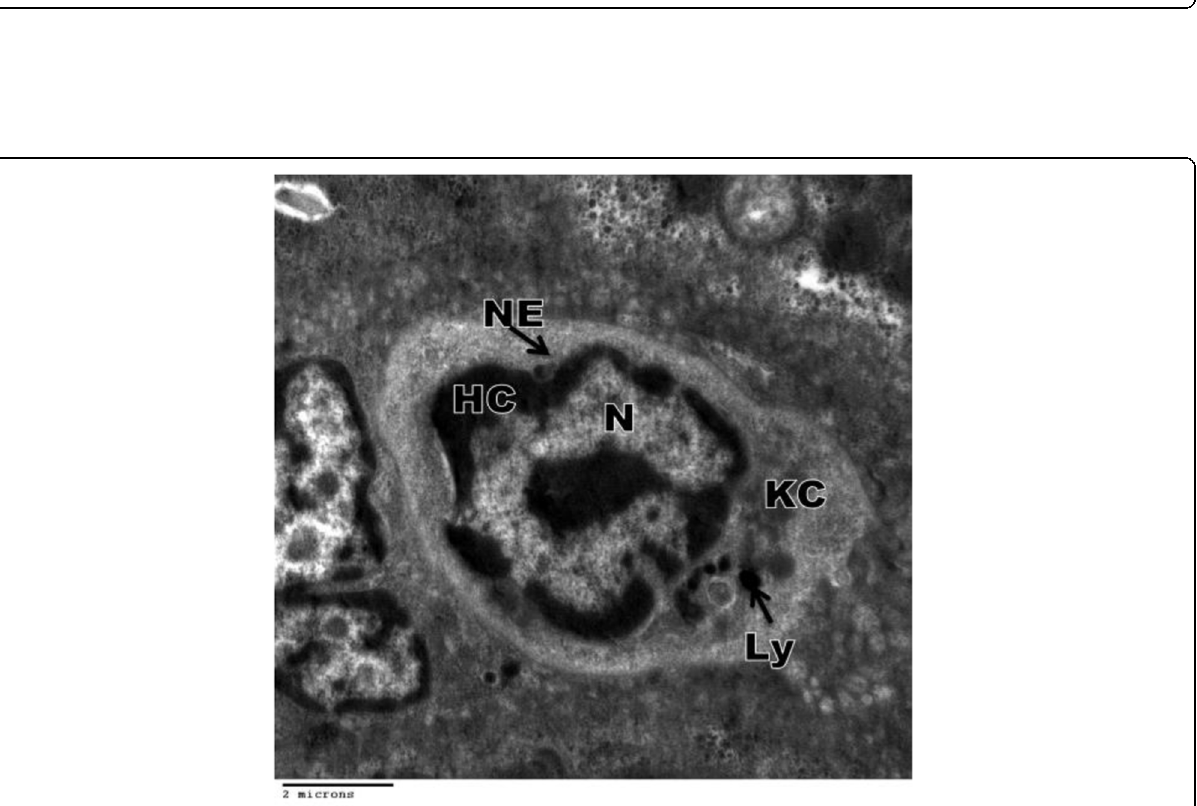
Fig. 30 An electron micrograph of a hepatocyte of treated mouse with Tamiflu (16 mg/kg b.wt.) in addition to Adamine (20 mg/kg b.wt.) for 15 days revealing lipid droplets (LD), glycogen rosette (*), and nucleus (N). (×